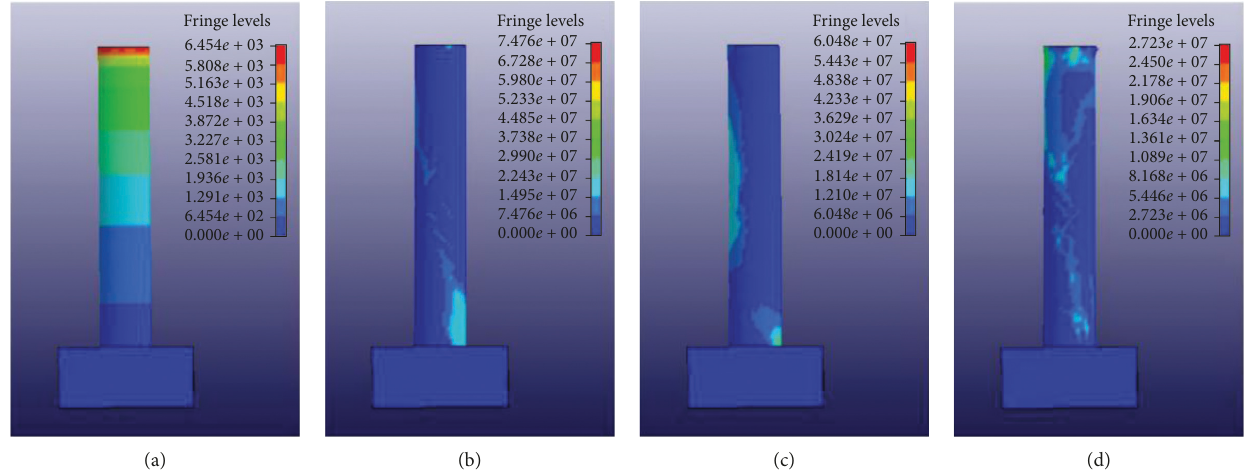
Figure 9: Stress nephogram of R1-8m (Unit: Pa): (a) R1-8 m ( T � 0.030s), (b) R1-8 m ( T � 0.035s), (c) R1-8 m ( T � 0.062s), and (d) R1-8 m ( T � 0.089s).